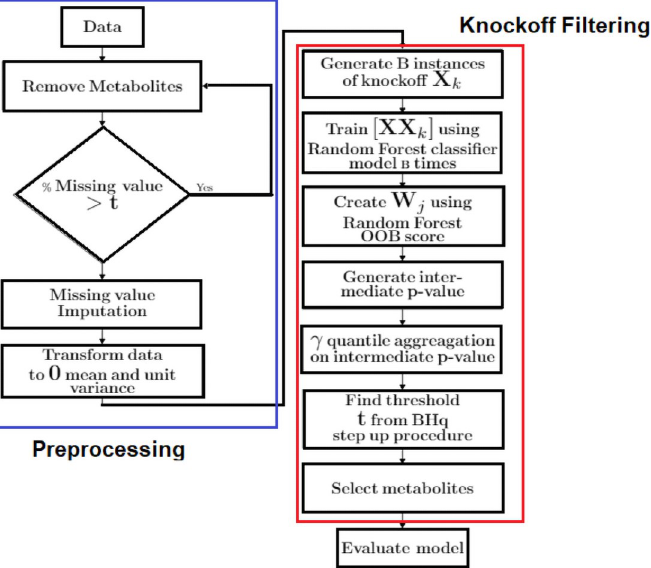
Fig 1. Workflow of the whole process. Blue box represents the data preprocessing step whereas blue box denotes the steps of knockoff filtering.